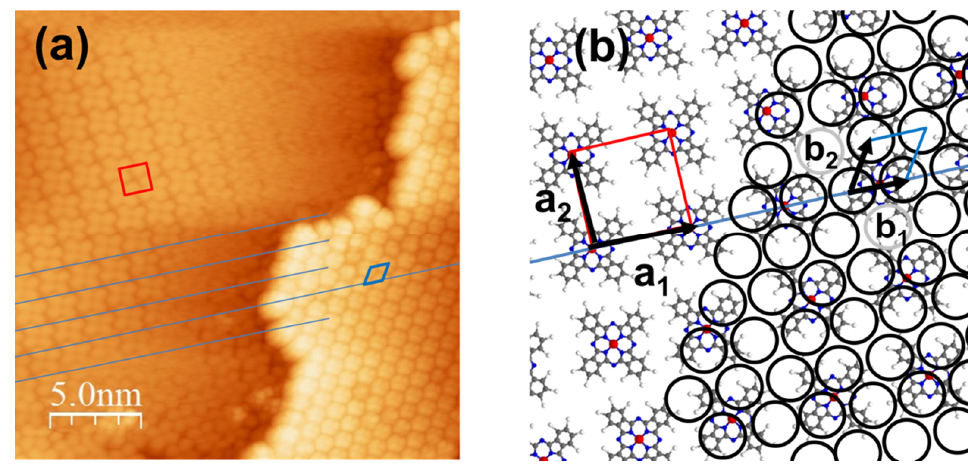
Figure 1. ( a ) STM topography of a C 60 island grown on a ZnPc layer on Ag(111), simultaneously showing the molecular resolution of both lattices, see the red square and the blue diamond; the blue lines indicate rows of ZnPc molecules (0.6 nA, − 0.4 V and T = 77 K). ( b ) Magnified schematic view corresponding to the STM topography, where the C 60 lattice (circles) is superposed on the ZnPc lattice. As indicated a 1 and b 1 are